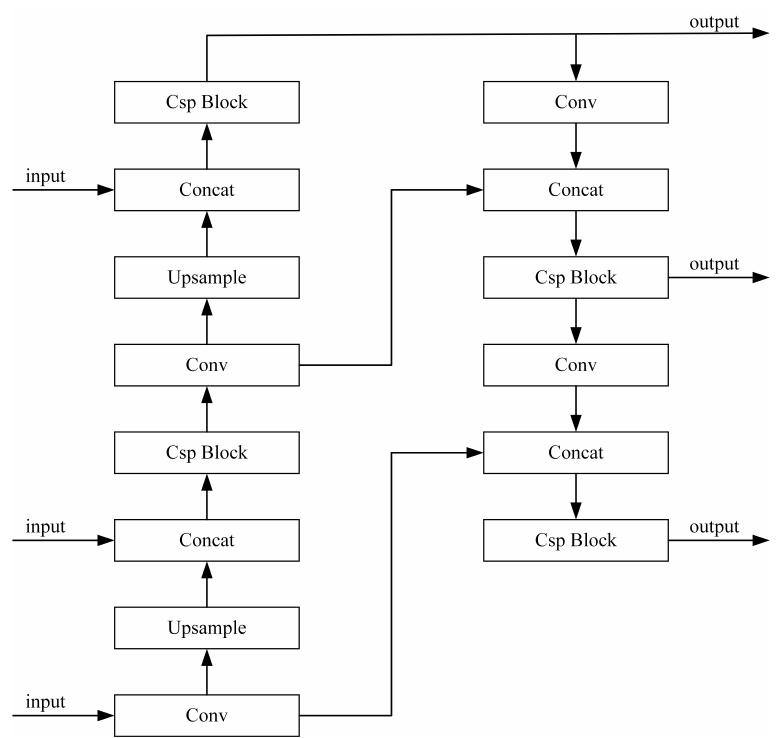
Figure 1. The structure of Shufflenet v2.